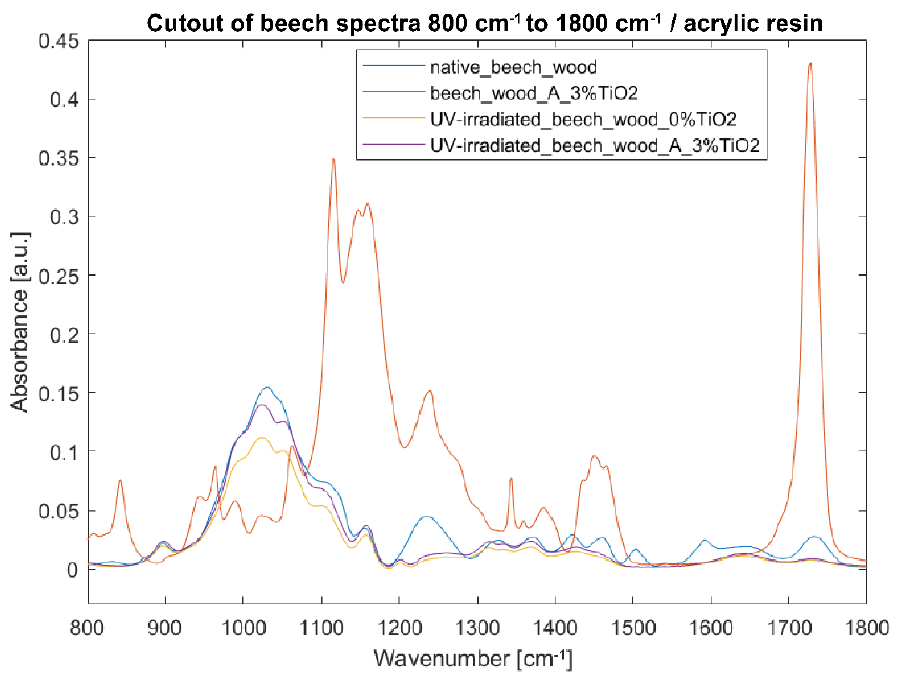
Figure 11. FTIR-ATR spectra of beech wood samples in the fingerprint region 800 – 1800 cm − 1 : (blue) reference sample of native beech wood, (red) beech wood with 3% TiO 2 acrylic coating, (yellow) UV-irradiated beech wood without TiO 2 coating, and (purple) UV-irradiated beech wood with 3% TiO 2 acrylic coating.